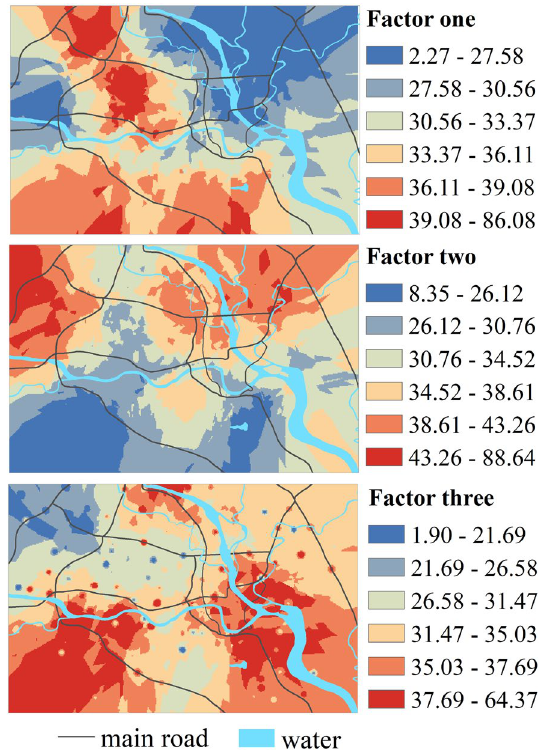
Figure 5. Spatial distribution of the contribution rate of the three sources [the figure was generated by Huaming Du using the ArcGIS 10.3 (https:// devel opers. arcgis.